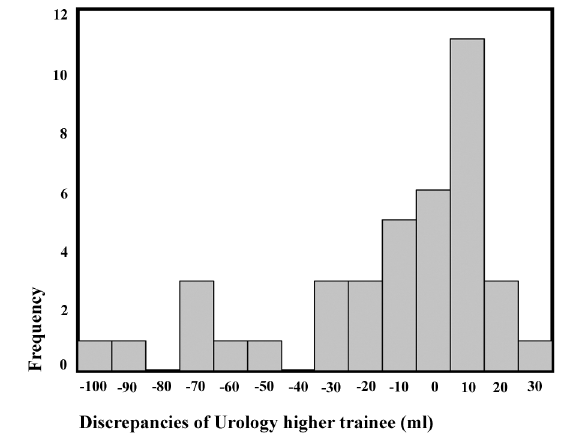
Figure 5 – Frequency distribution of discrepancies for urology higher trainee.